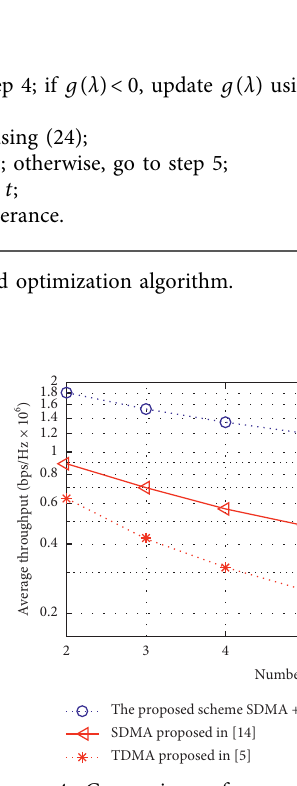
Figure 4: Comparison of average user throughput about the proposed scheme and the traditional schemes with L � 8, N � 2, σ 2 � − 50dBm/Hz, and η � 0 .